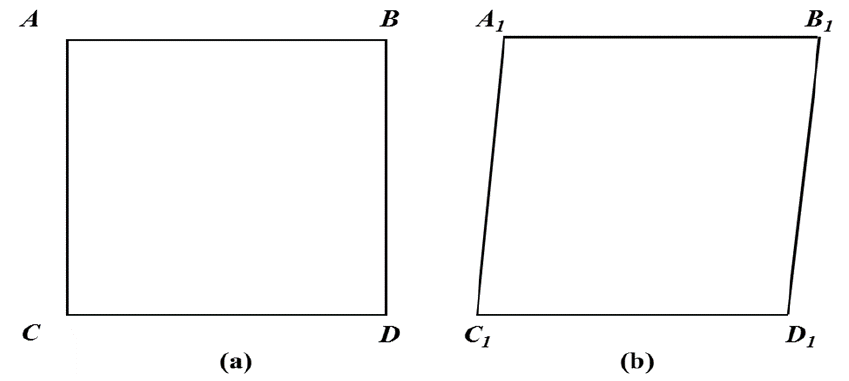
Figure 5. ( a ) Calibration pattern and ( b ) distortion pattern.